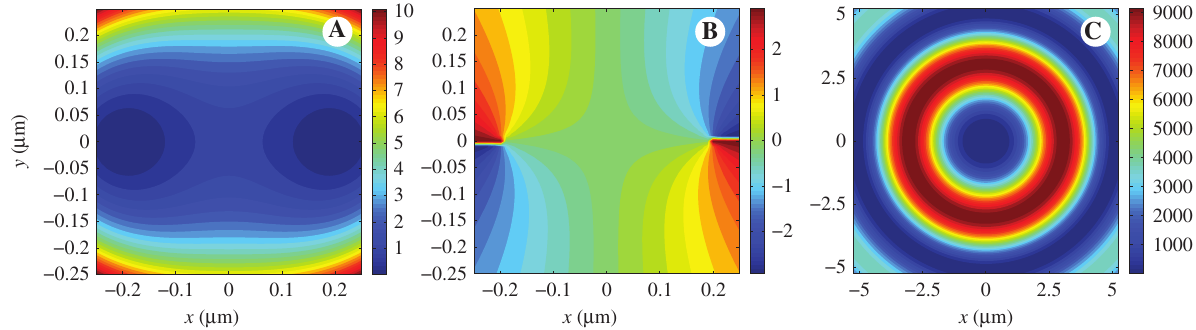
Figure 13: The (A), (C) intensity and (B) phase of a nondiffracting beam with superoscillations. Here λ = 1 μ m, a = 2 μ m −1 , and δ = 0.2 μ